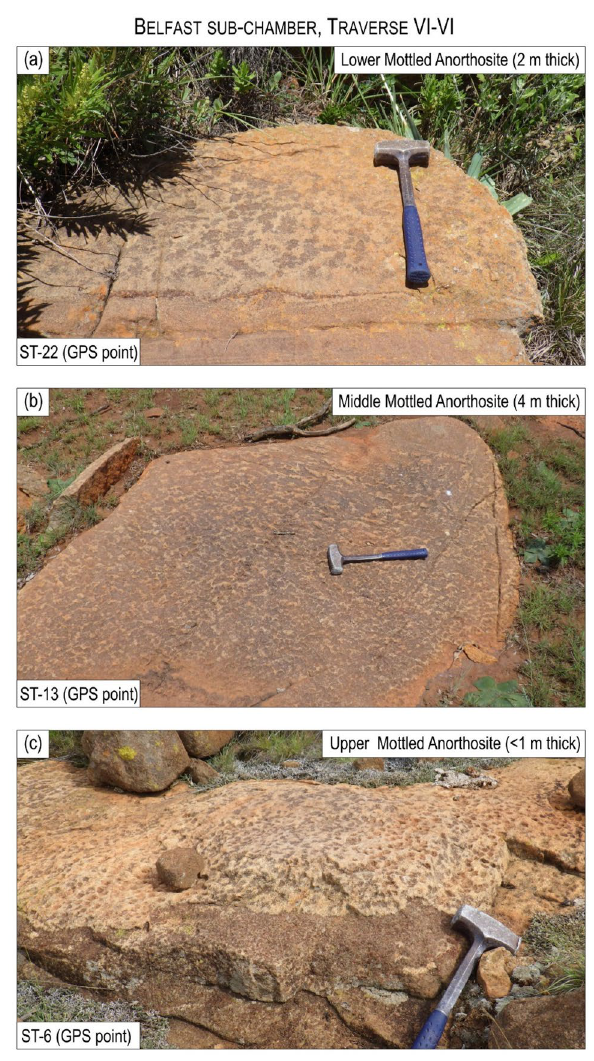
Figure 5. Photos of field outcrops of the three Anorthosite Markers along the traverse VI-VI of the Belfast sub- chamber of the southeastern part of the Bushveld Complex. All photos were taken by Sofya